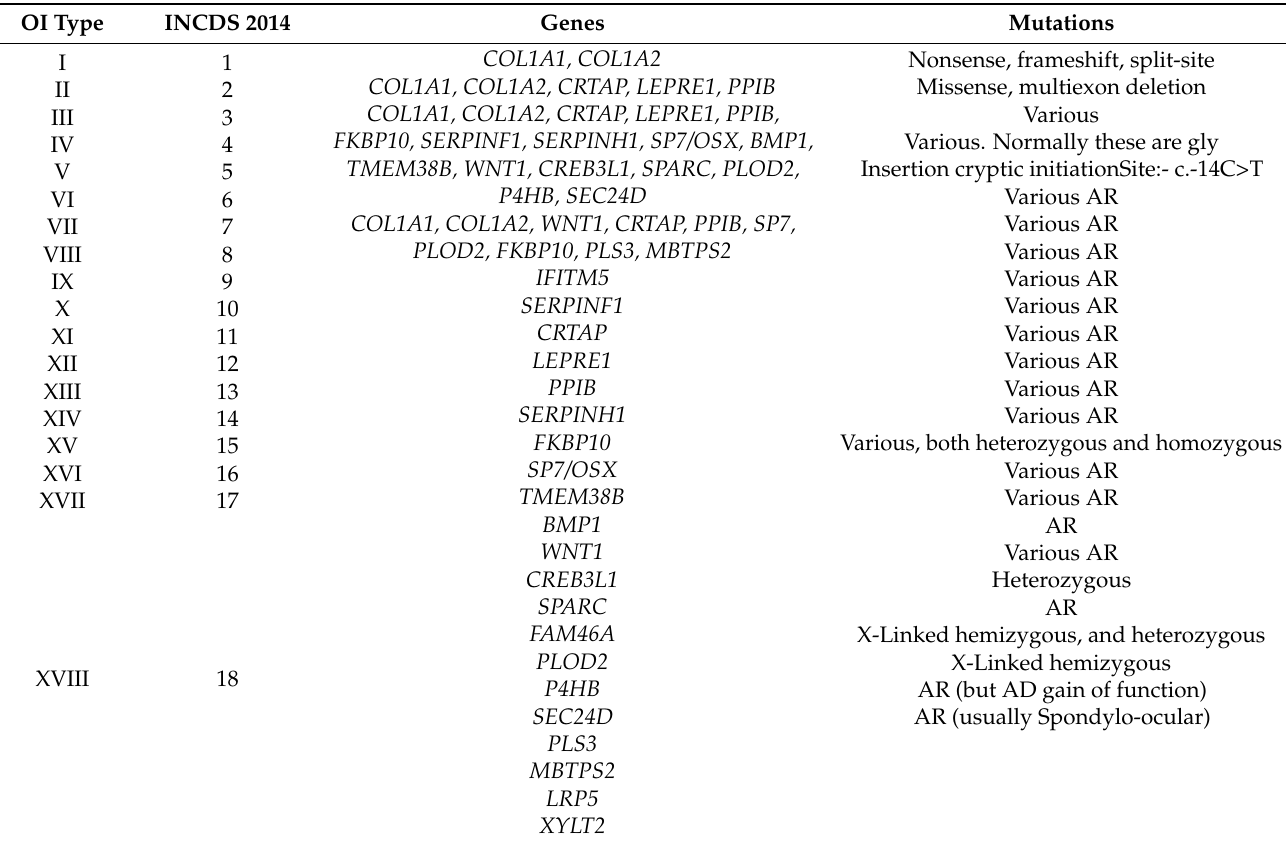
Table 10. Comparison Nosology OMIM vs. International Nosology Committee.